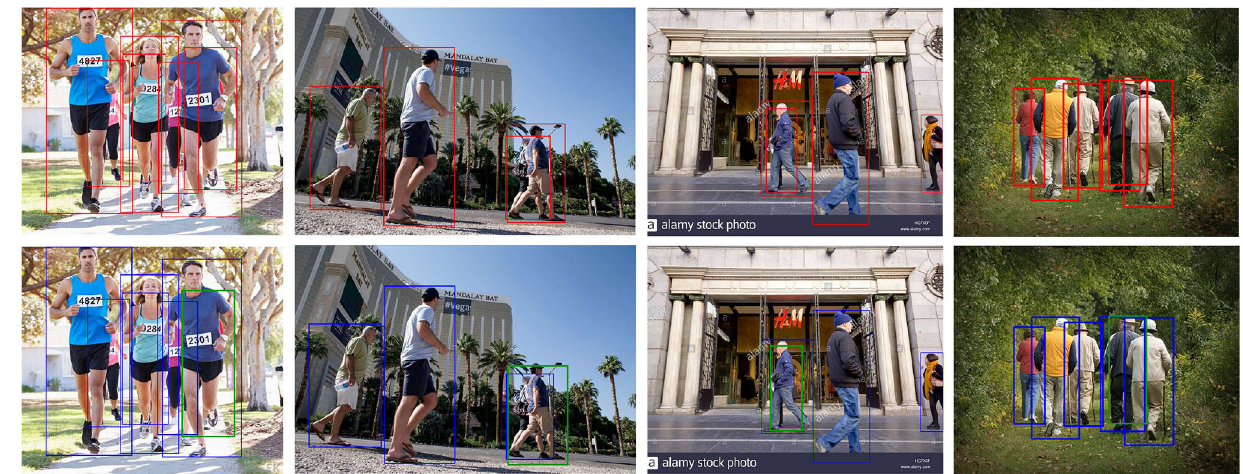
Fig. 8 Qualitative results on CrowdHuman. The red boxes are prediction boxes generated by our YOLOC, the blue boxes are the prediction results of baseline, and the green boxes are the boxes missed by the baseline but detected by the